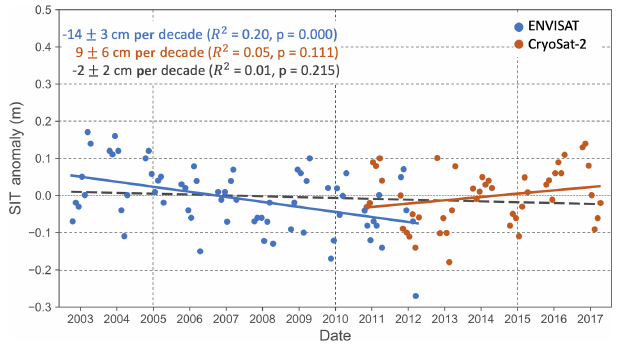
Figure 2. ESA CCI-2 gridded (25km EASE grid) sea ice thick- ness (SIT) anomaly in the Laptev Sea. SIT anomaly was calculated for each month compared to the mean of the same month over the full period from 2002 to 2017. Anomalies were calculated for every grid point and averaged over a predefined area in the Laptev Sea (70–81.5 ◦ N, 100–145 ◦ E, enclosed area Fig. 1). R 2 provides the goodness of fit for each trend